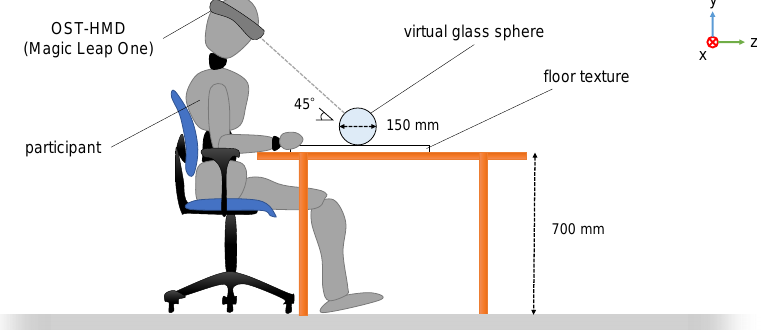
Figure 12. Experimental